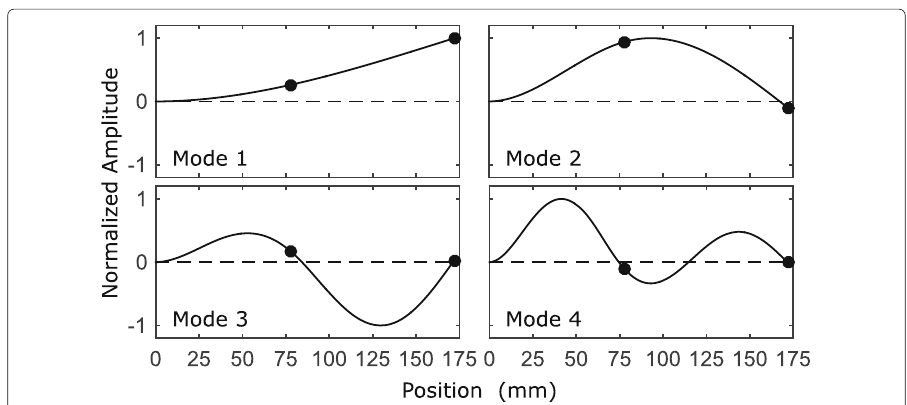
Fig. 4 Calculated shape functions of the first four eigenmodes of the cantilever. The amplitudes are normalized to the maximum local amplitude, respectively. The markers indicate the positions x 1 and x 2 of the two point masses M 1 and M 2 , which represent the mirror and the target